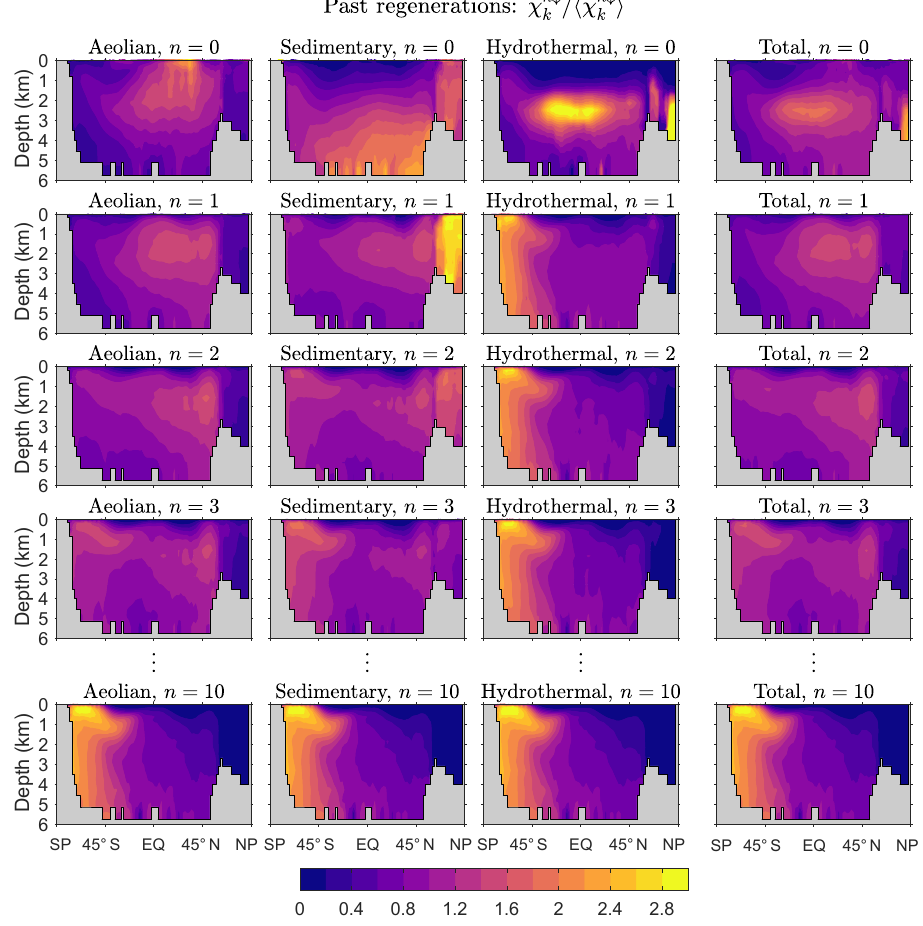
Figure 2. Global zonal averages of the concentration of DFe that was regenerated n times since birth, normalized by its global mean, for n = 0 , 1 , 2 , 3 , and 10. The normalized concentrations of the three source types (aeolian, sedimentary, hydrothermal) are shown, as is their sum, which is the total concentration regardless of source type. This figure is for our typical